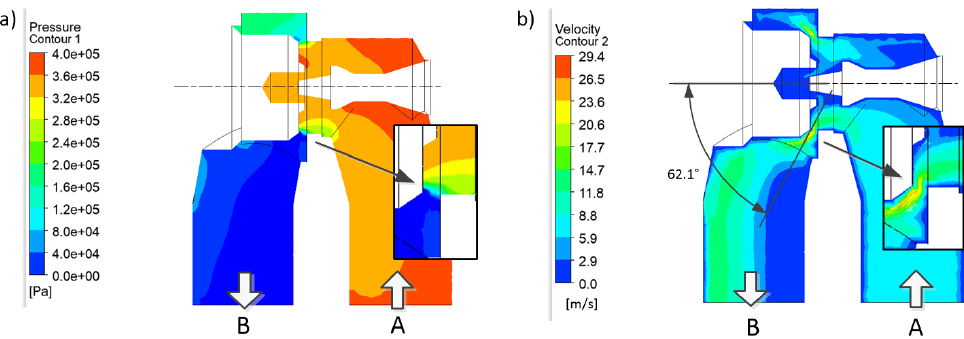
Figure 5. Results of CFD simulation for poppet position x p = 1.0 mm: ( a ) pressure distribution, ( b ) velocity distribution; λ = 67.8 ◦ .